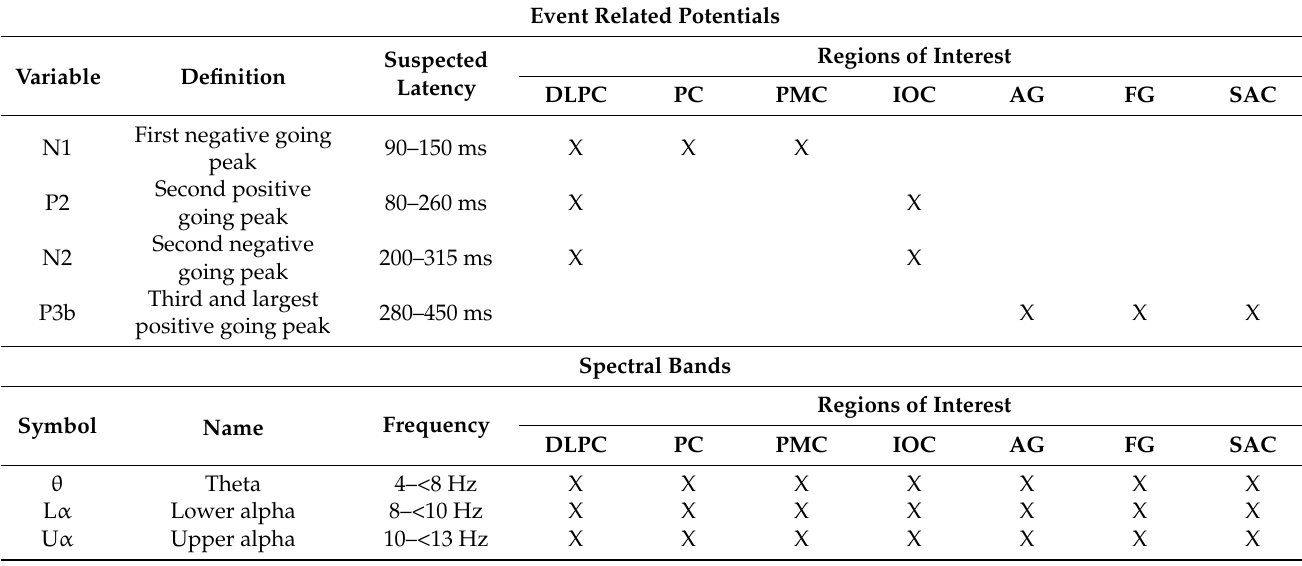
Table 1. Definitions, localisations and suspected latencies of Spectral power and ERPs of